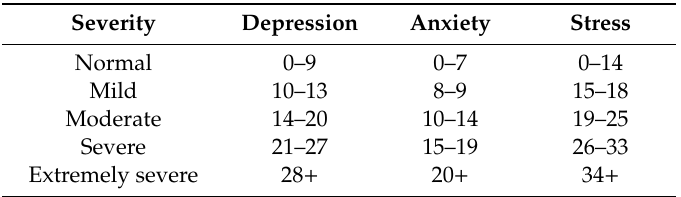
Table 1. Cuto ff points for DASS-21